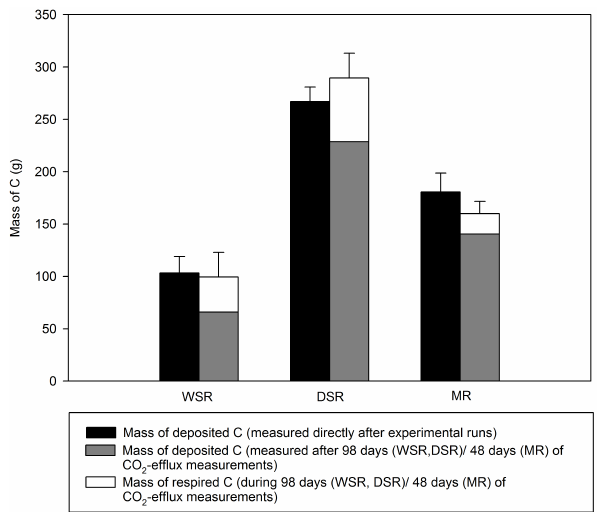
Fig. 6. Comparison between the mass of deposited C, directly after the experimental runs (M1) and the sum of the mass of respired CO 2 -C and the mass of C in deposited sediments after CO 2 -efflux measurements